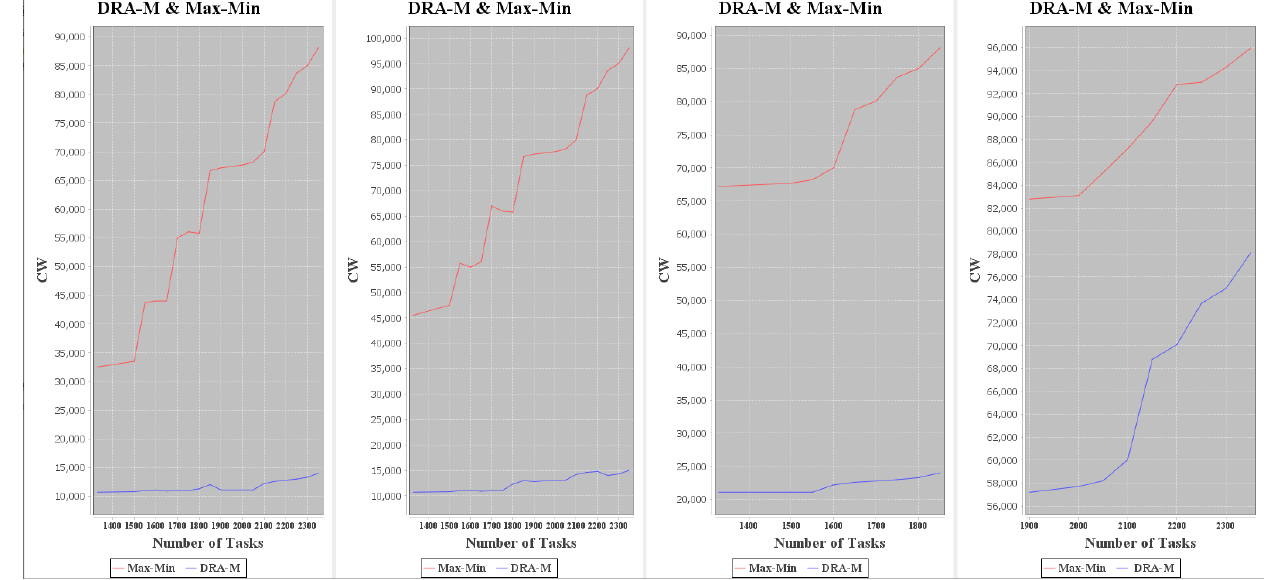
Figure 8. CW comparison of Max-Min and DRA-M algorithms.